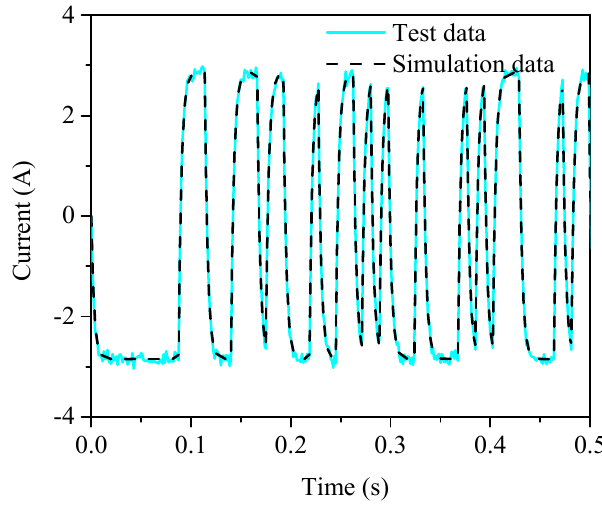
Figure 5. Comparison of the simulation data and test data using the SRIV algorithm.